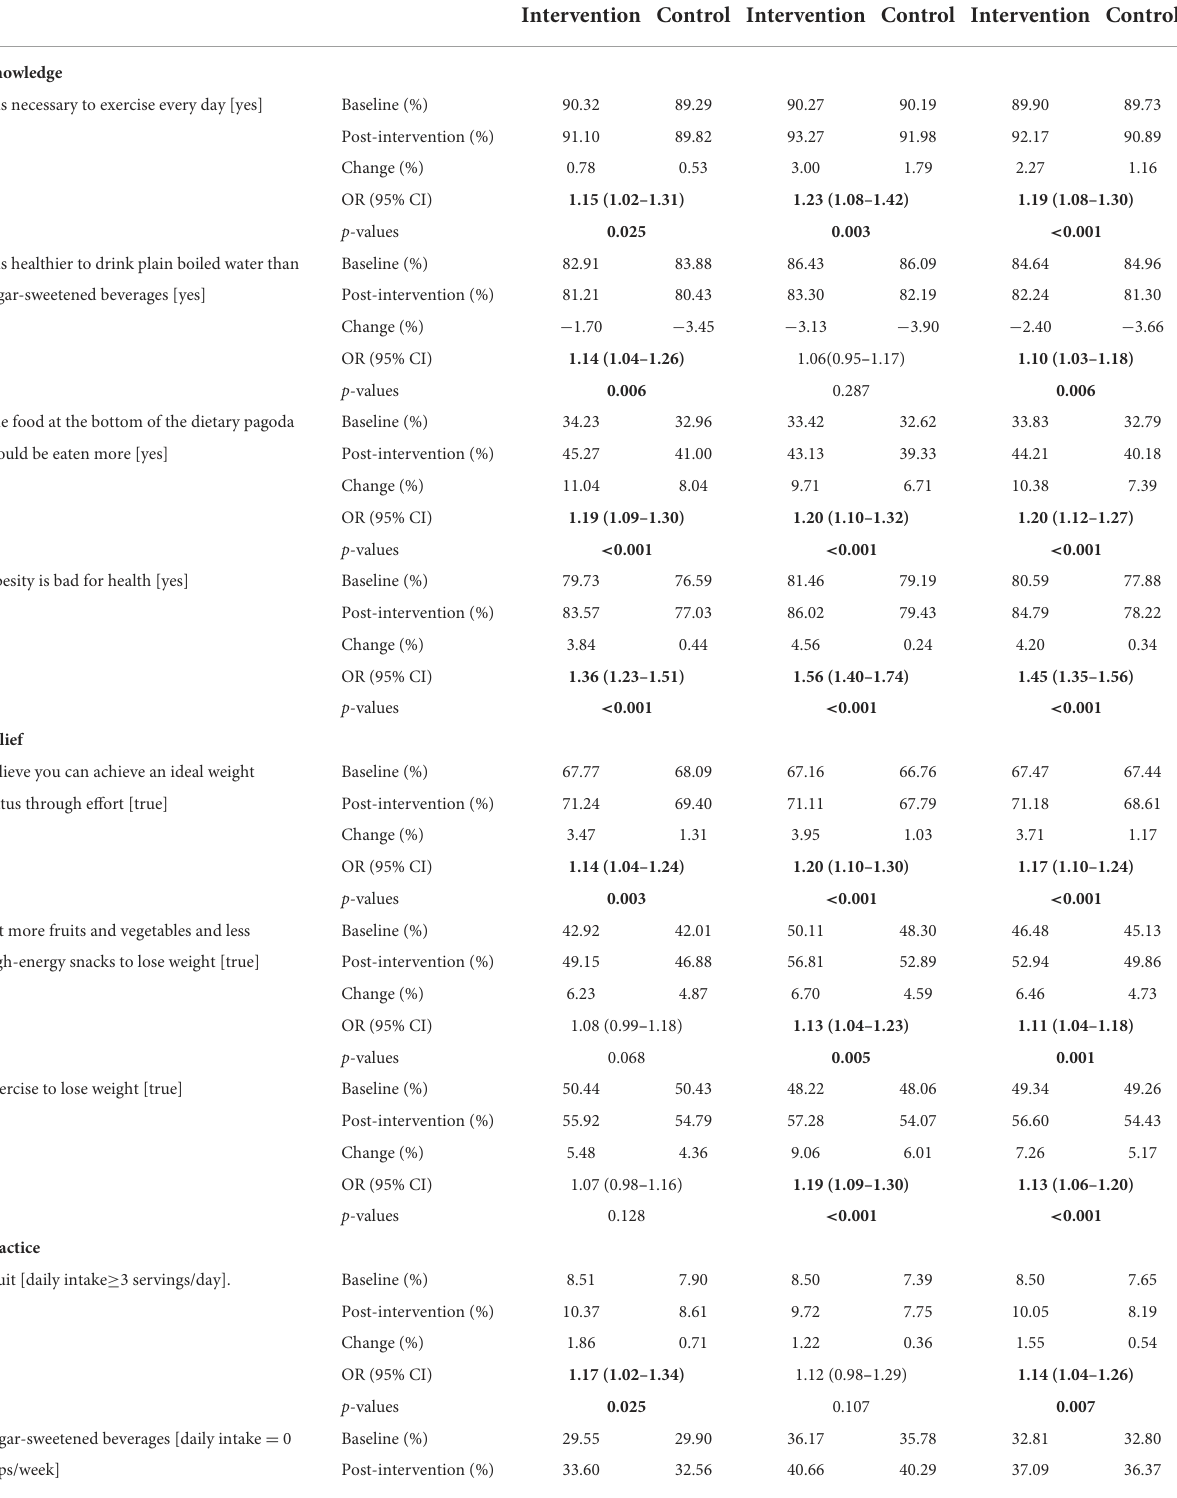
TABLE 2 Effectiveness on the student’s knowledge, belief, and